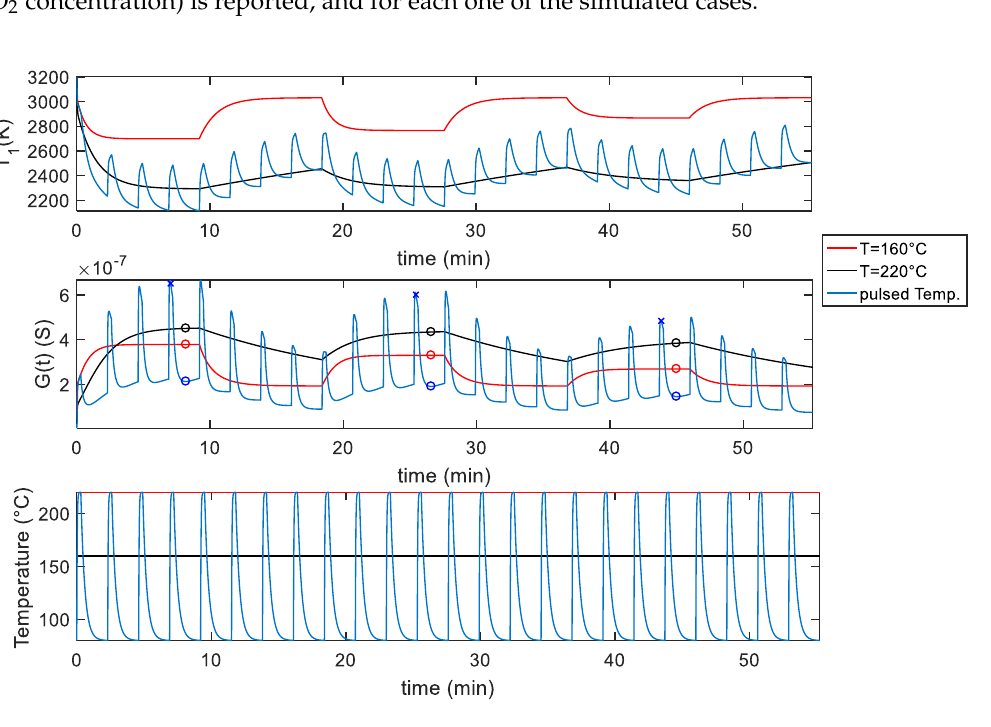
Figure 8. Simulation results for the G and T 1 behavior for the SWCNT-TiO 2 decorated sensor sample, assuming the temperature profiles shown in the bottom plot of the figure. The measurement gas profile is as follow: 9.2 min carrier gas + 37 ppm NO 2 , 9.2 min carrier gas, 9.2 min carrier gas + 25 ppm NO 2 , 9.2 min carrier gas, 9.2 min carrier gas + 12 ppm NO 2 , 9.2 min carrier gas, related temperature as per legend. For the markers, see Figure 9.